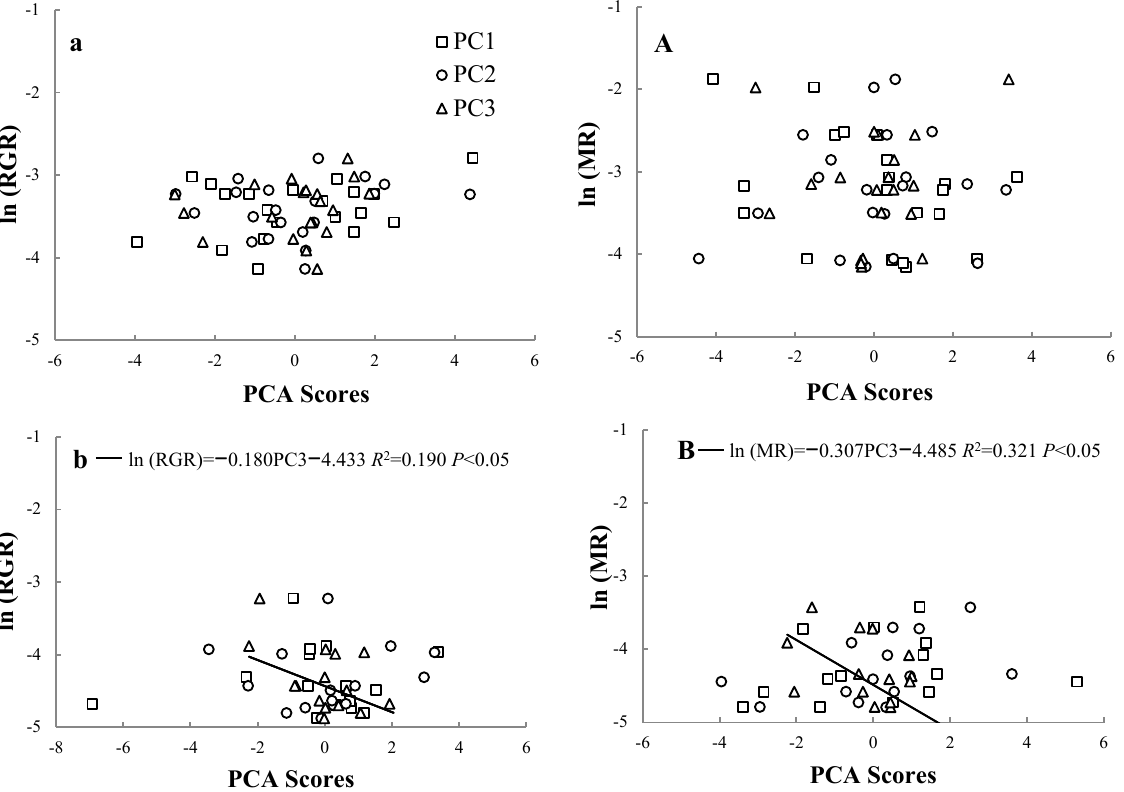
Figure 3. Linear regression of RGR and MR shown as PCA scores at different life stages. The straight line indicates that the PCA scores are significantly correlated with RGR and MR. The letter ( a , A ) represents saplings (1 cm ≤ DBH < 10 cm). The letter ( b , B ) represents large trees (DBH ≥ 10 cm).